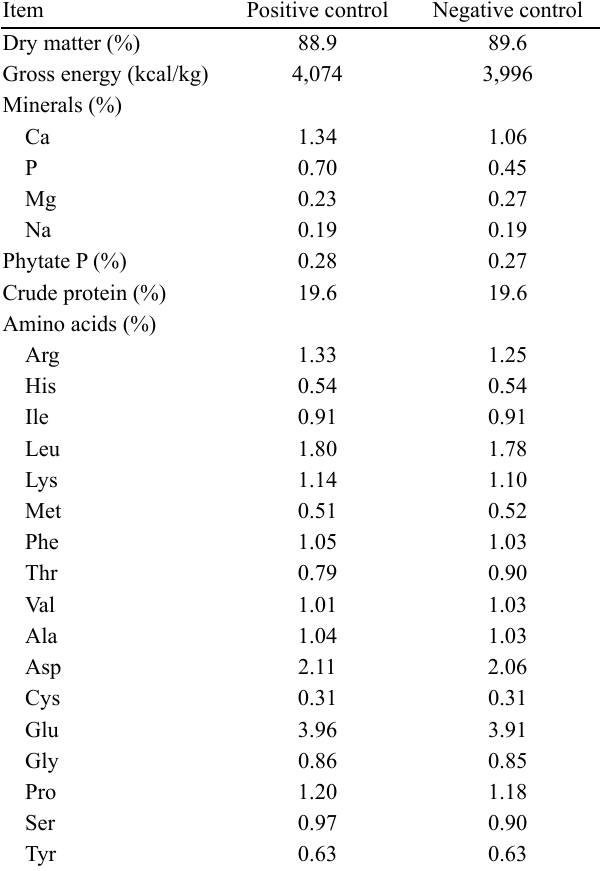
Table 2. Analyzed chemical composition of the basal diets, as